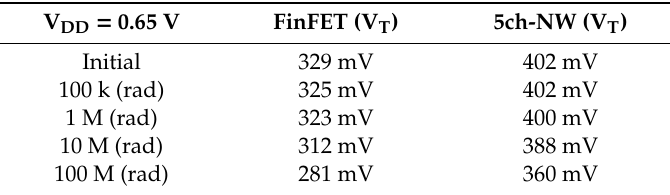
Table 2. V T data of each device according to the amount of TID.